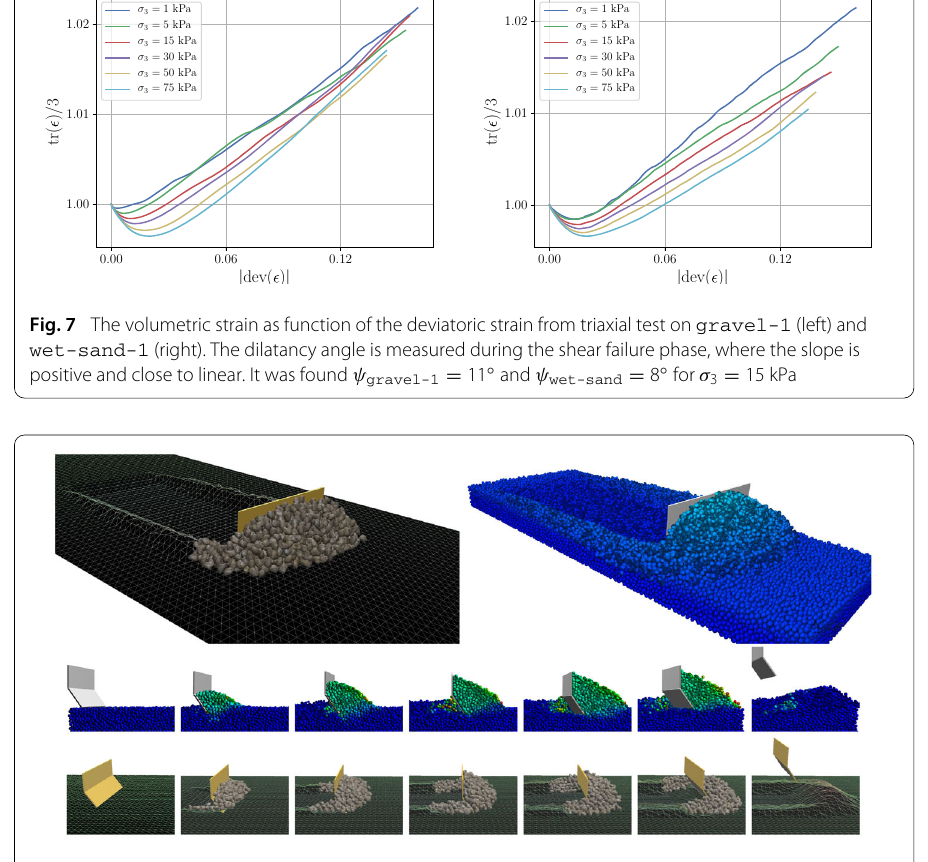
Fig. 8 Simulated bulldozing for comparing the multiscale terrain model (left) and the microscale reference model (right, particles colour coded by particle height position) at time 8 s and using material sand-1 . Second and third row show sideview of the microscale model (particles colour coded by velocity, blue to red by 0 to 1.5 m/s) and the multiscale model, at time 0, 2, 4, 6, 8, 10 and 12 s. See Additional file 3: Video